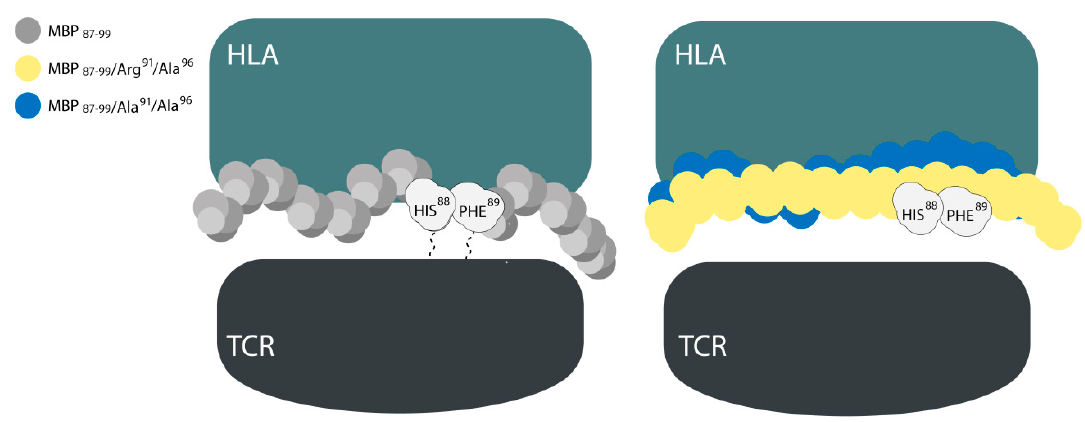
Figure 4. The replacement of Arg 41 or Arg 41 and Arg 46 of hMOG 35–55 with Ala interrupts the hydrogen bonding (HB) with the amino acids Asp 98 , Ser 101 , and Asn 104 of T-cell receptors (TCR). This may be due to the decrease of polarity of Ala vs. Arg (disruption of the interaction network) and may lead to a reduced bending of Ala in the low energy conformation of hMOG 35–55 . HLA—Human Leukocyte Antigen.